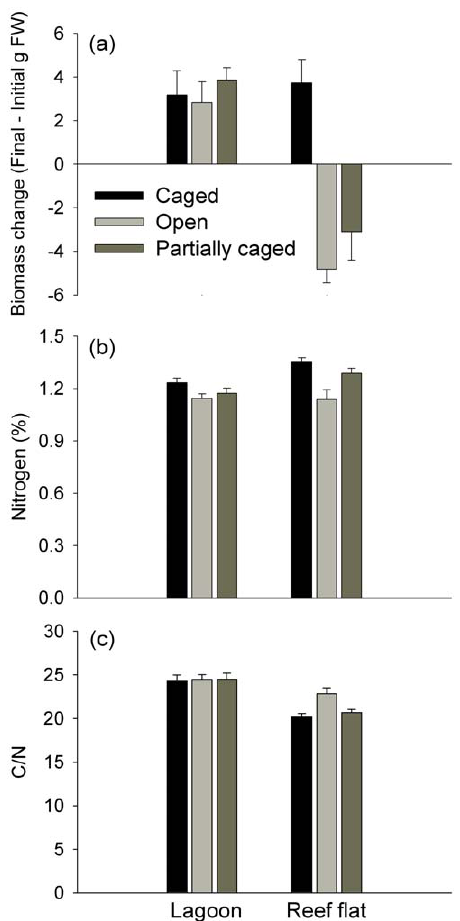
Figure 4. Relationships between rates of herbivory, algae cover and rugosity. (a) Logarithmic relationship between herbivory rates and algal cover. (b) Linear relationship between herbivory rates and rugosity. All variables were averaged for each site.